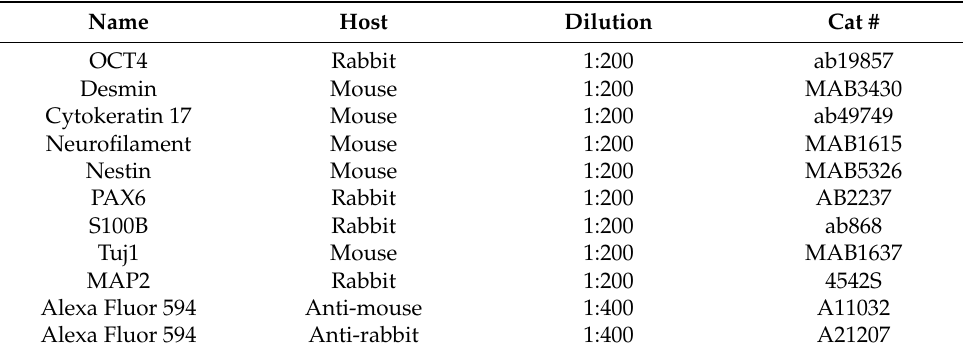
Table 1. Antibodies used for immunofluorescence